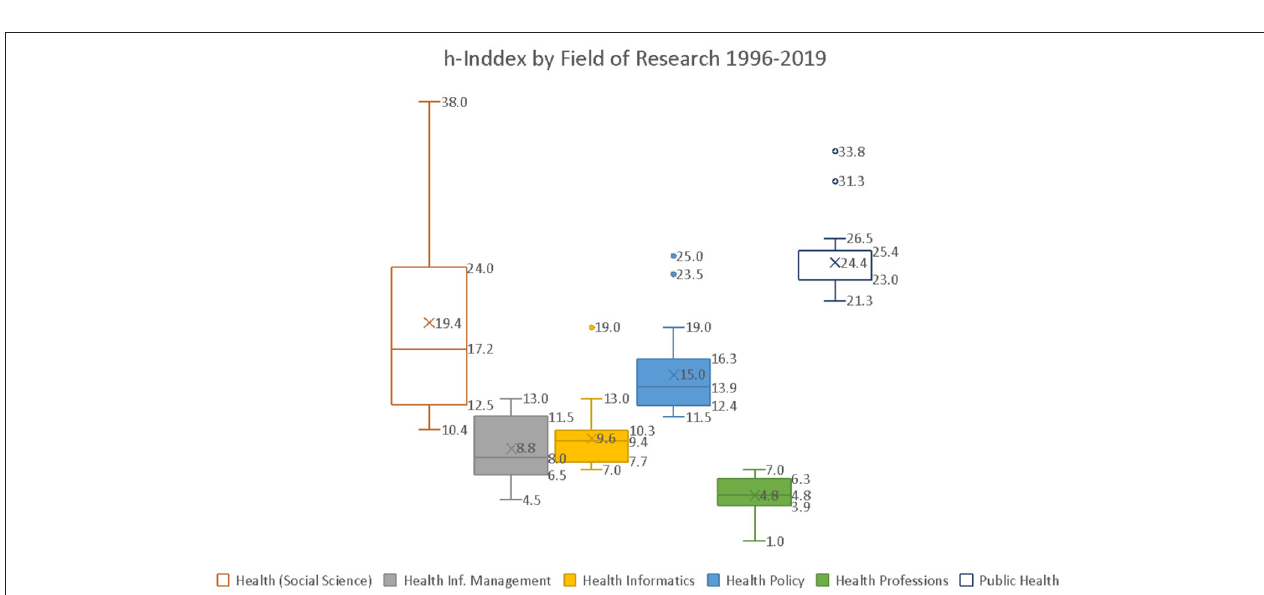
FIGURE 2 | Published citable articles in Web of Science database during 1996–2019 adjusted to population size.